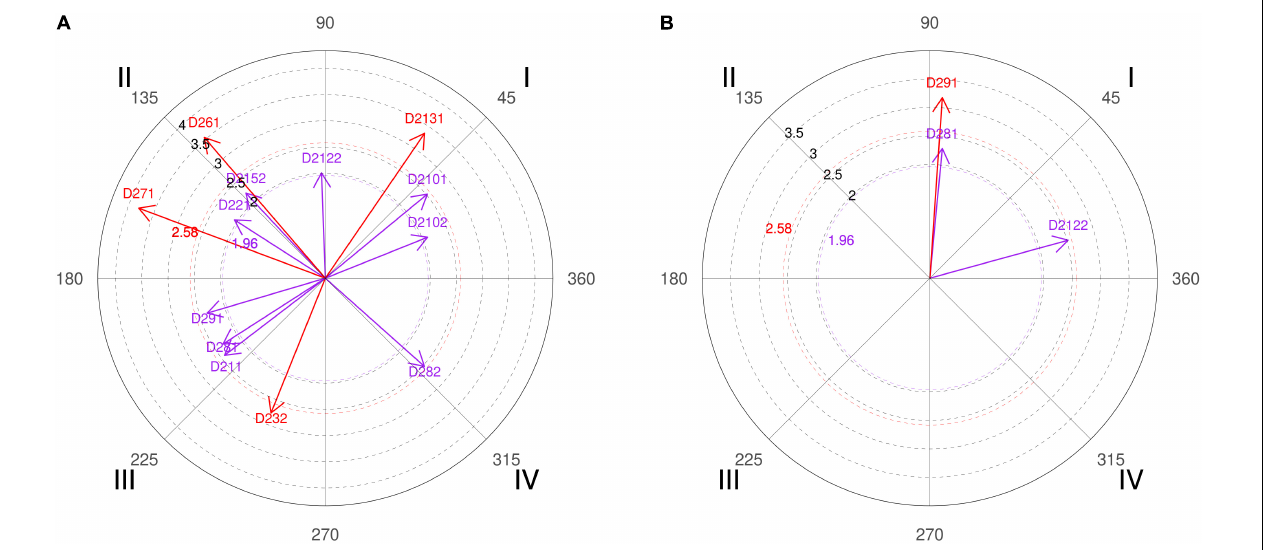
FIGURE 6 | (A,B) Relationship of conditioned behaviors that present a significant relationship with the focal behaviors “favorable evaluation” and “unfavorable evaluation” analyzing question 11 of the in-depth interviews. In “favorable evaluation,” a total of 13 significant vectors were detected, and in “unfavorable evaluation,” a total of three significant vectors were